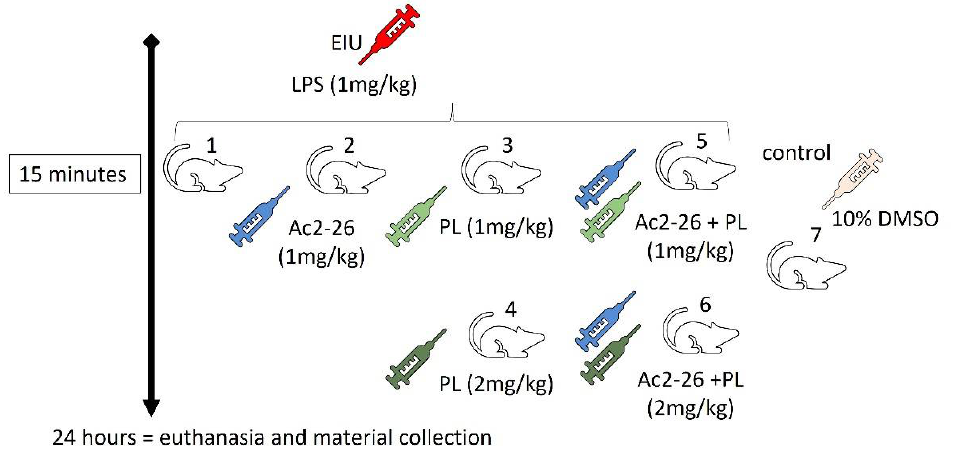
Figure 1. Schematic representation of experimental groups. Induced by ( 1 ) LPS, ( 2 ) LPS and treated with Ac2-26 200 µg diluted in PBS, ( 3 ) LPS and treated with PL 200 µg diluted in 10% DMSO, ( 4 ) LPS and treated with PL 400 µg diluted in 10% DMSO, ( 5 ) LPS and treated with Ac2-26 200 µg diluted in PBS and PL 200 µg diluted in 10% DMSO, ( 6 ) LPS and treated with Ac2-26 200 µg diluted in PBS and PL 400 µg diluted in 10% DMSO, and ( 7 ) uninduced, administered with 10% DMSO ( n = 5/group). Rats that received an intraperitoneal injection of 10% DMSO were used as the control group. The animals were anesthetized with isoflurane (1%) before each